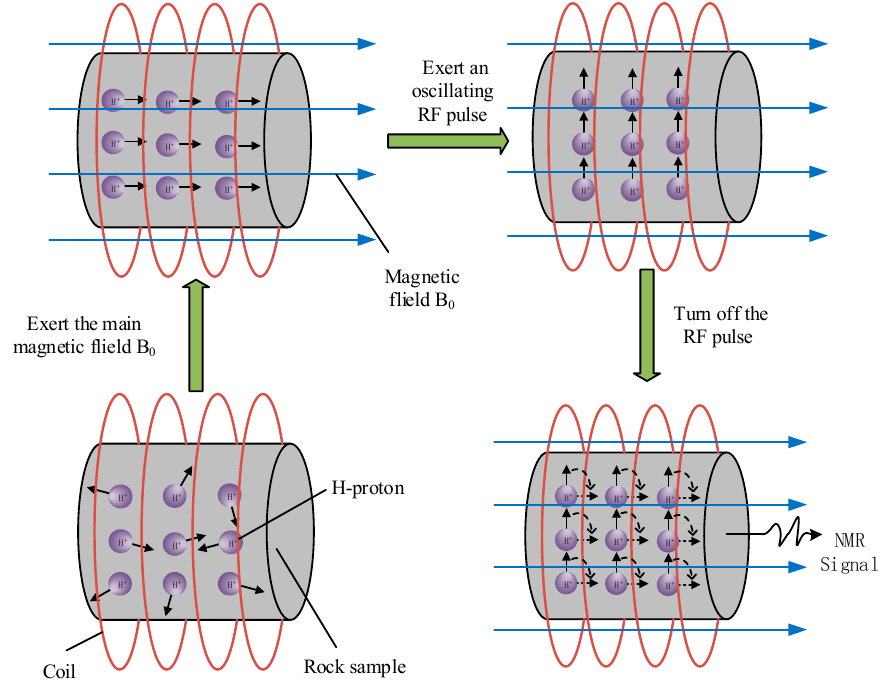
Figure 4. Schematic diagram of the magnetic resonance image (MRI) test mechanism.